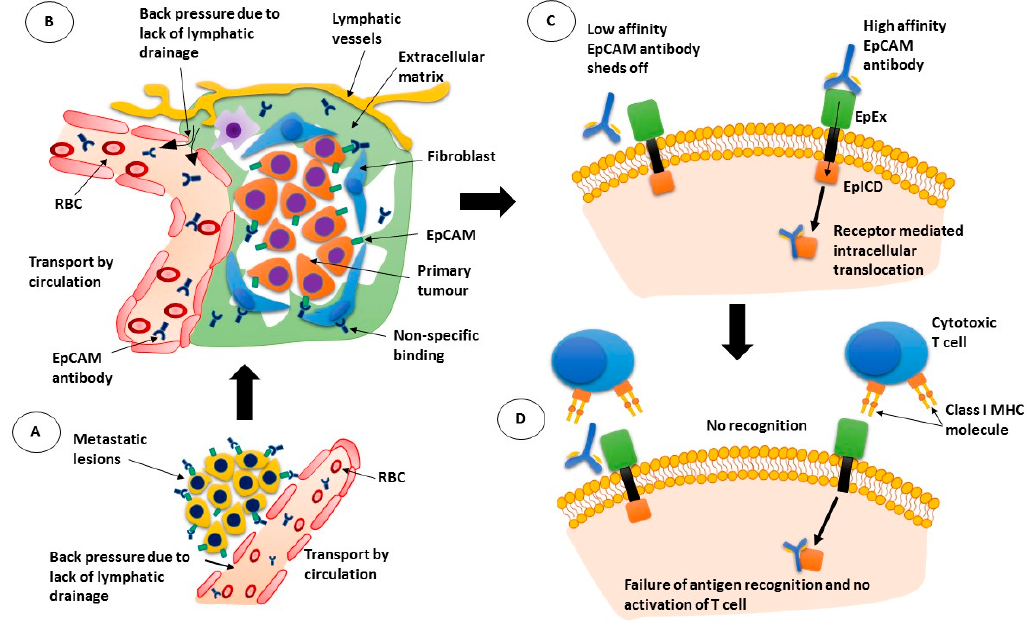
Figure 1. Mechanism of action of epithelial cell adhesion molecule (EpCAM) antibodies. ( A ) antibodies pass through the leaky blood vessel walls but are moved back into circulation due to back pressure; ( B ) while the EpCAM antibodies can bind to tumour cells, they can also bind to other cells non-specifically; ( C ) low affinity antibodies may not remain bound to their target while high affinity antibodies may be internalised with the receptor; ( D ) If the antibody is internalised, cytotoxic T cells are not activated. RBC: red blood cell; EpEx: extracellular domain of EpCAM; EplCD: intracellular domain of EpCAM; MHC: major histocompatibility complex.